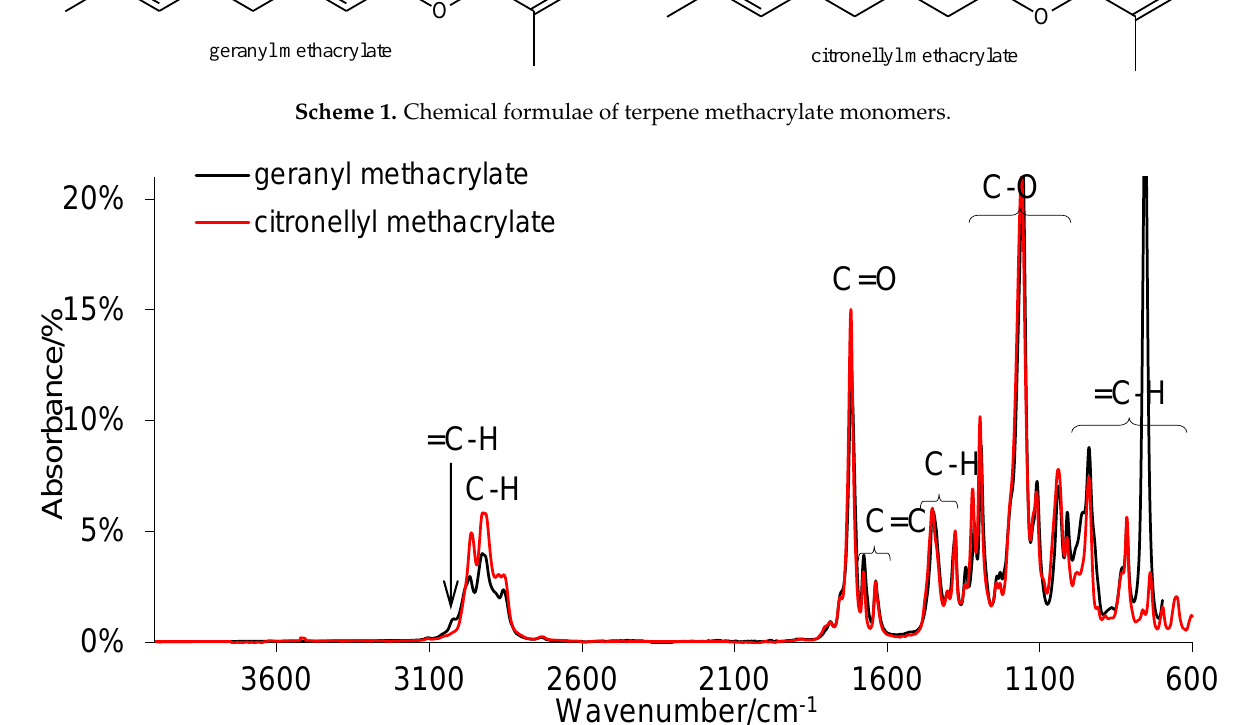
Figure 1. ATR-FTIR spectra for terpene methacrylate monomers. Table 2. Basic properties of methacrylate monomers.